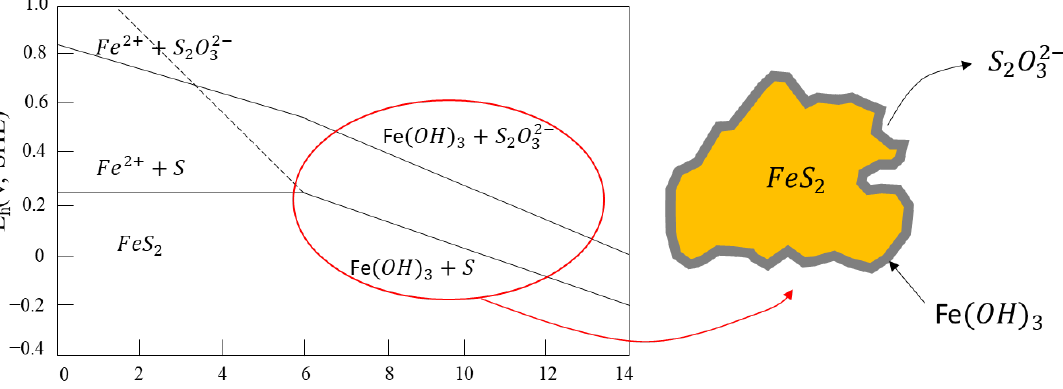
Figure 24. Eh-pH diagram for pyrite in aqueous solutions shows the metal hydroxide and sulfate formation zone. The equilibrium lines correspond to species dissolved at 10 −4 mol/L (adapted from Hu et al. [111].